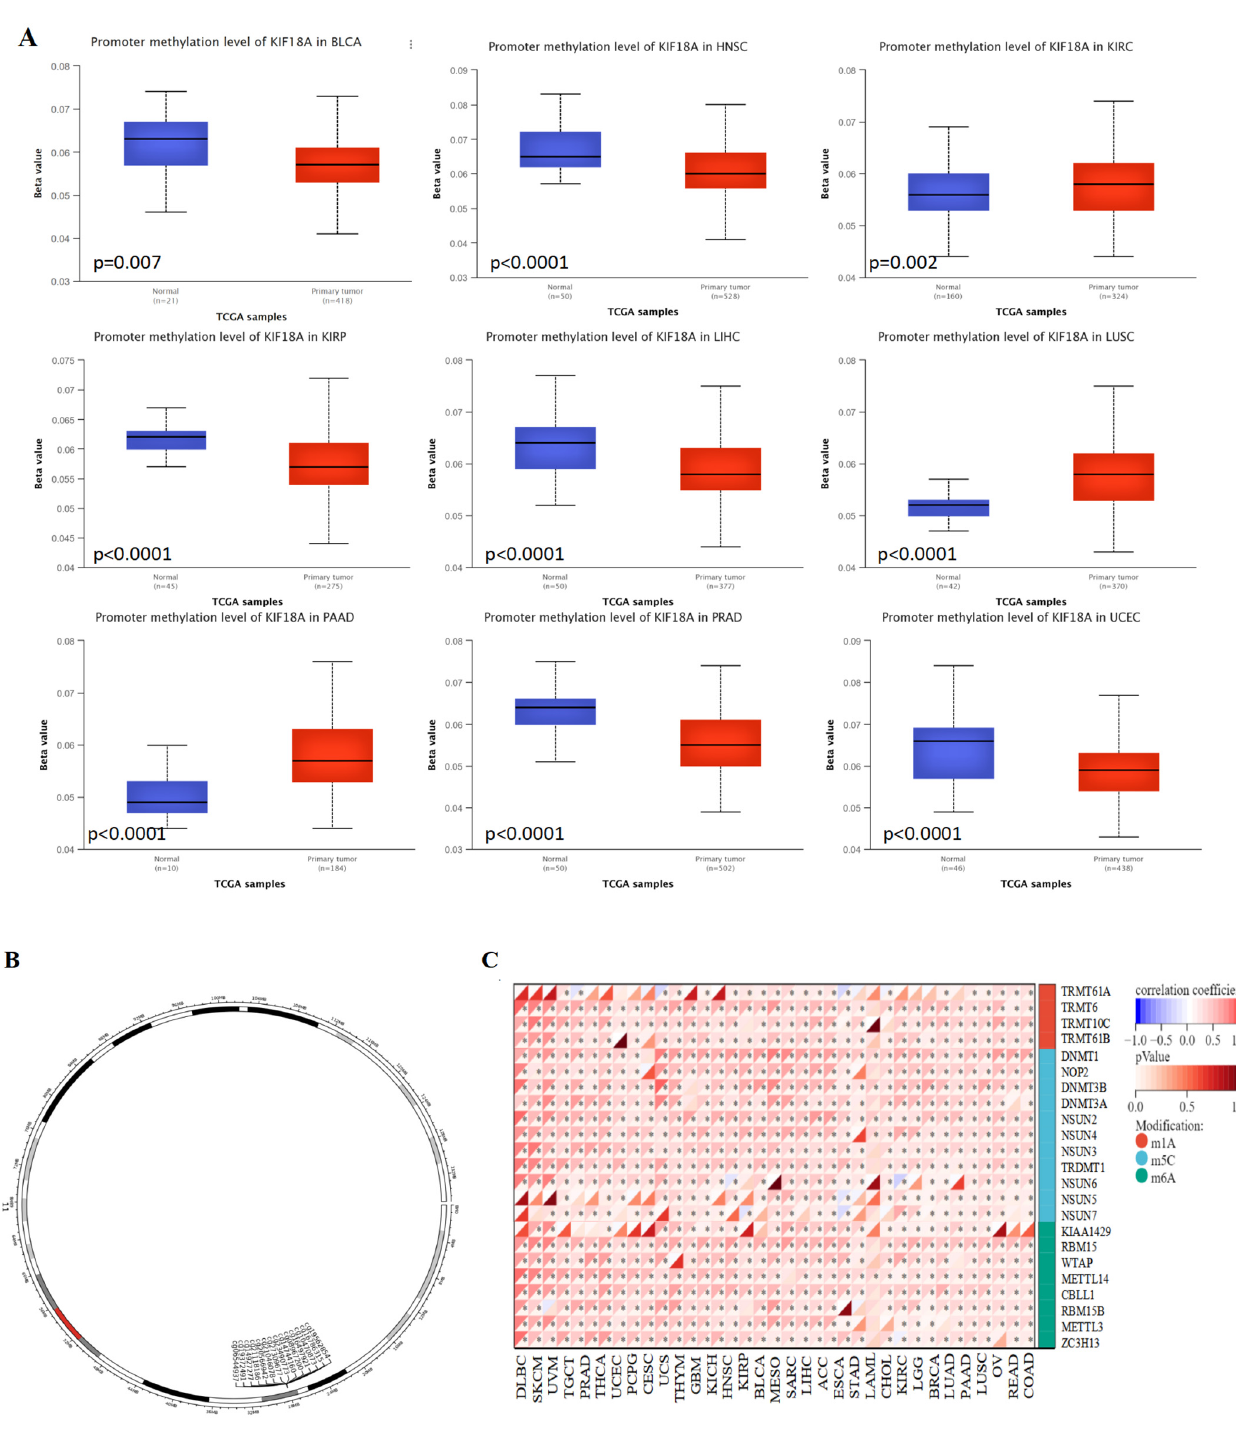
Figure 8. Relationship of KIF18A with methylation and methyltransferase. ( A ) Promoter methylation level of KIF18A in BLCA, HNSCC, KIRC, KIRP, LIHC, LUSC, PAAD, PRAD, and UCEC. ( B ) Chromo- somal distribution of the methylation probes associated with KIF18A. ( C ) The correlation between KIF18A expression and m 1 A, m 5 C, m 6 A regulatory genes. * p <